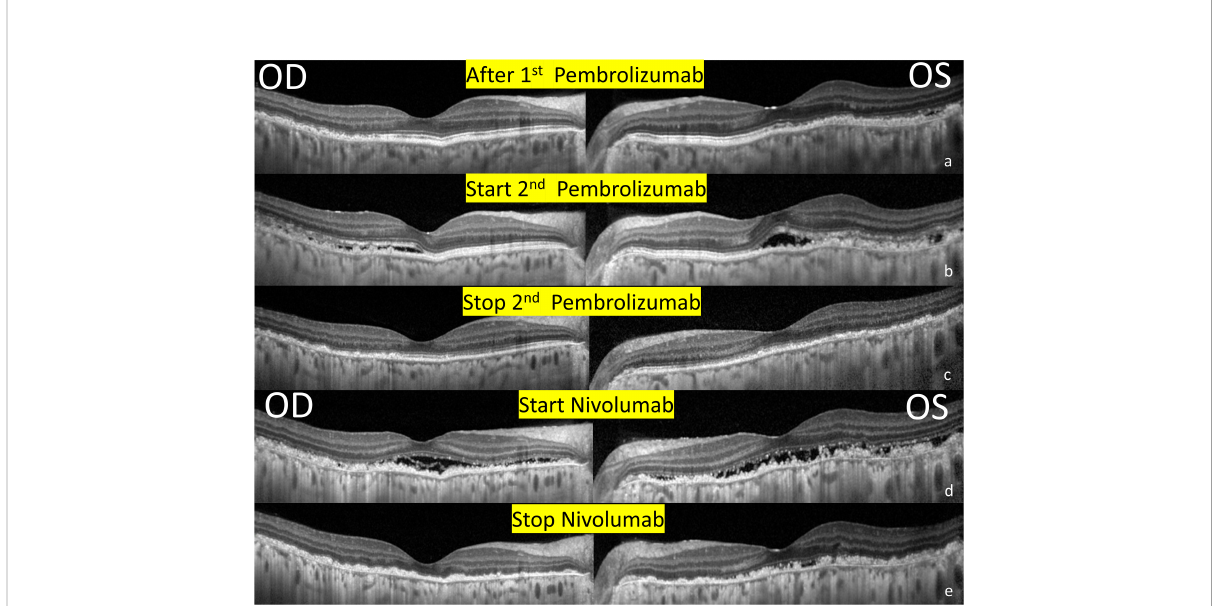
FIGURE 2 Serial changes in optical coherence tomography of the bilateral eyes. (A) 1 month after receiving immunotherapy with pembrolizumab. Note the RPE and outer retinal destruction over the heterogenous changes of the superior and temporal region. (B) 1 week after receiving 2 nd Pembrolizumab. Multiple subretinal fl uids with RPE and outer retinal destruction involving the fovea developed. (C) After the discontinuation of pembrolizumab. A resolution of SRF but extensive RPE and outer retina destruction remained the same. (D) After receiving immunotherapy with nivolumab. New subretinal fl uids with more prominent RPE and outer retinal destruction involving the fovea. (E) After the discontinuation of Nivolumab. A resolution of SRF and sustained extensive RPE and outer retina